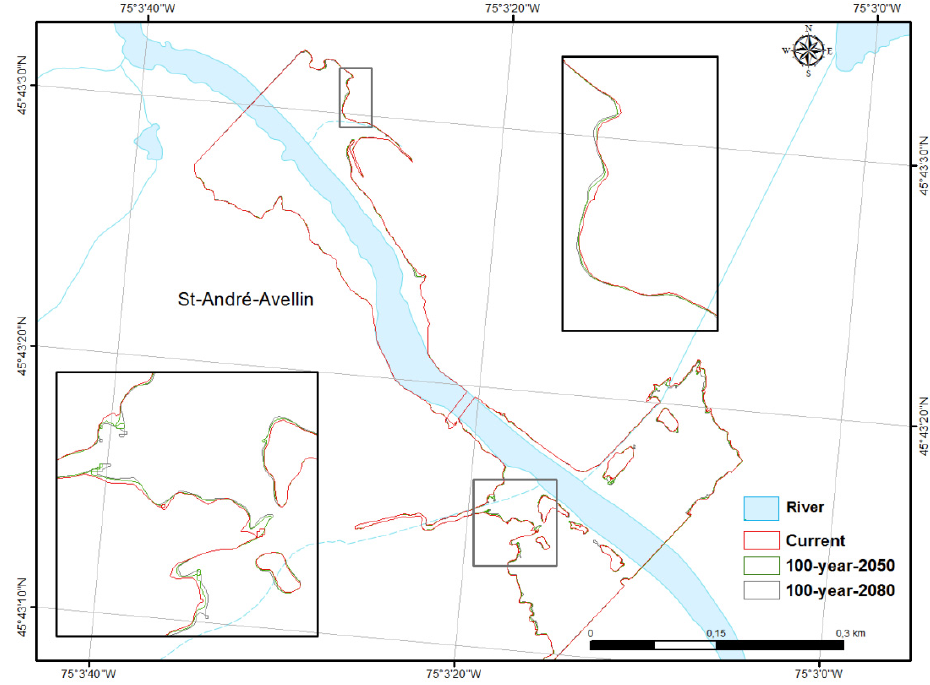
Figure A4. Flood extent for a 100-year return period, under current, 2050, and 2080 horizons (RCP 8.5). Case: St-Andre-Avellin.